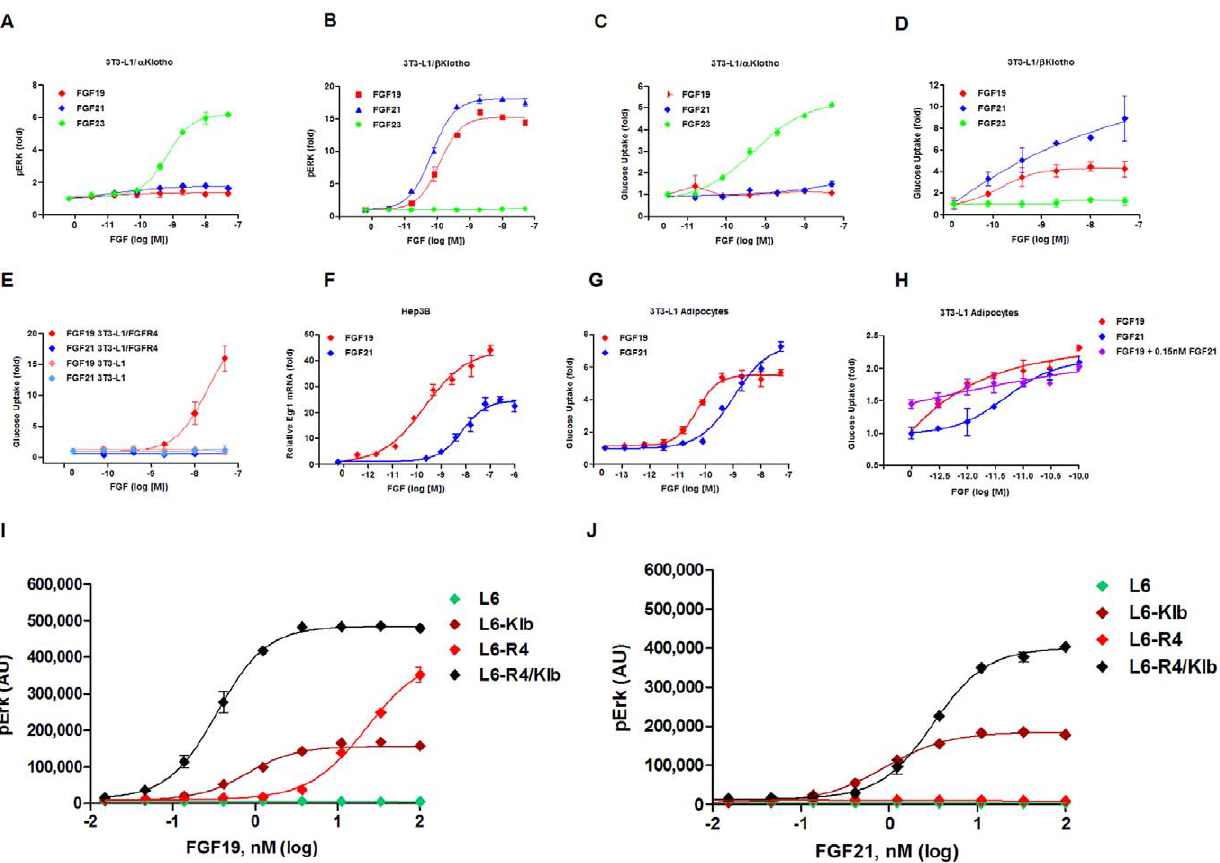
Figure 2. The ‘‘hormone like’’ FGFs exhibit different signaling properties in vitro. Panel 1. In 3T3-L1 fibroblasts over-expressing KL we saw phosphorylation of the FGF target ERK upon treatment with FGF23, while FGF19 and 21 had no effect (A). Conversely, in 3T3-L1/KLB cells we saw no effect of FGF23 but potent signaling with FGF19 or FGF21 treatment (B). When we examined glucose uptake in the 3T3-L1/KL cells we found that only FGF23 lead to its stimulation (C). As we saw with pERK in 3T3-L1/KLB cells FGF19 and FGF21 both increased glucose uptake significantly (D). In 3T3-L1 fibroblasts expressing FGFR4 in the absence of KLB only FGF19 was able to increase glucose uptake (E). Furthermore, in Hep3B cells which show a relative enrichment of FGFR4, FGF19 was significantly more potent than FGF21 in inducing expression of the immediate early gene EGR1 (F). When 3T3-L1 cells were differentiated to become mature adipocytes FGF19 was also more potent than FGF21 even in the absence of FGFR4 expression suggesting a possible unknown factor which is not present on fibroblasts may be affecting FGF19’s action in these cells, or vice versa (G). In 3T3-L1 adipocytes treated with either FGF19, FGF21 or a combination of both we did not see any additive or synergistic effects of combination treatment over individual therapy suggesting FGF19 and FGF21 share a common mechanism of action (H). To confirm our initial results regarding the specificity of FGF19 for FGFR4 we turned to L6 cells which have been reported to have extremely low expression of FGFRs and KLs. In parental L6 cells treatment with FGF19 had no effect on the level of ERK phosphorylation, however, when cells were transfected with KLB a small but significant increase in pERK was detected. Furthermore, when FGFR4 was added the response to FGF19 stimulation was magnified. Interestingly, we saw again that in cells transfected with FGFR4 alone FGF19 was also able to induce pERK confirming KLB independent signaling with this ligand can occur (I). In contrast to FGF19, cells treated with FGF21 showed pERK induction only in the presence of KLB with the level of this baseline induction similar to that seen with FGF19 treatment